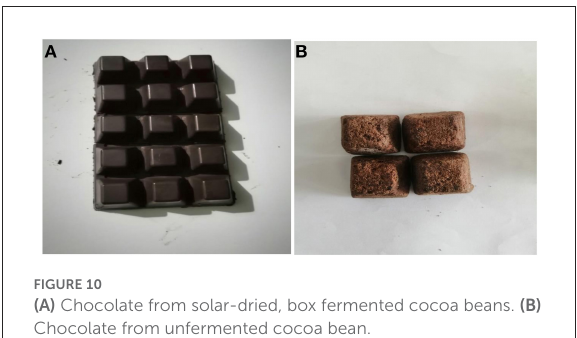
FIGURE10 (A) Chocolate from solar-dried, box fermented cocoa beans. (B) Chocolate from unfermented cocoa